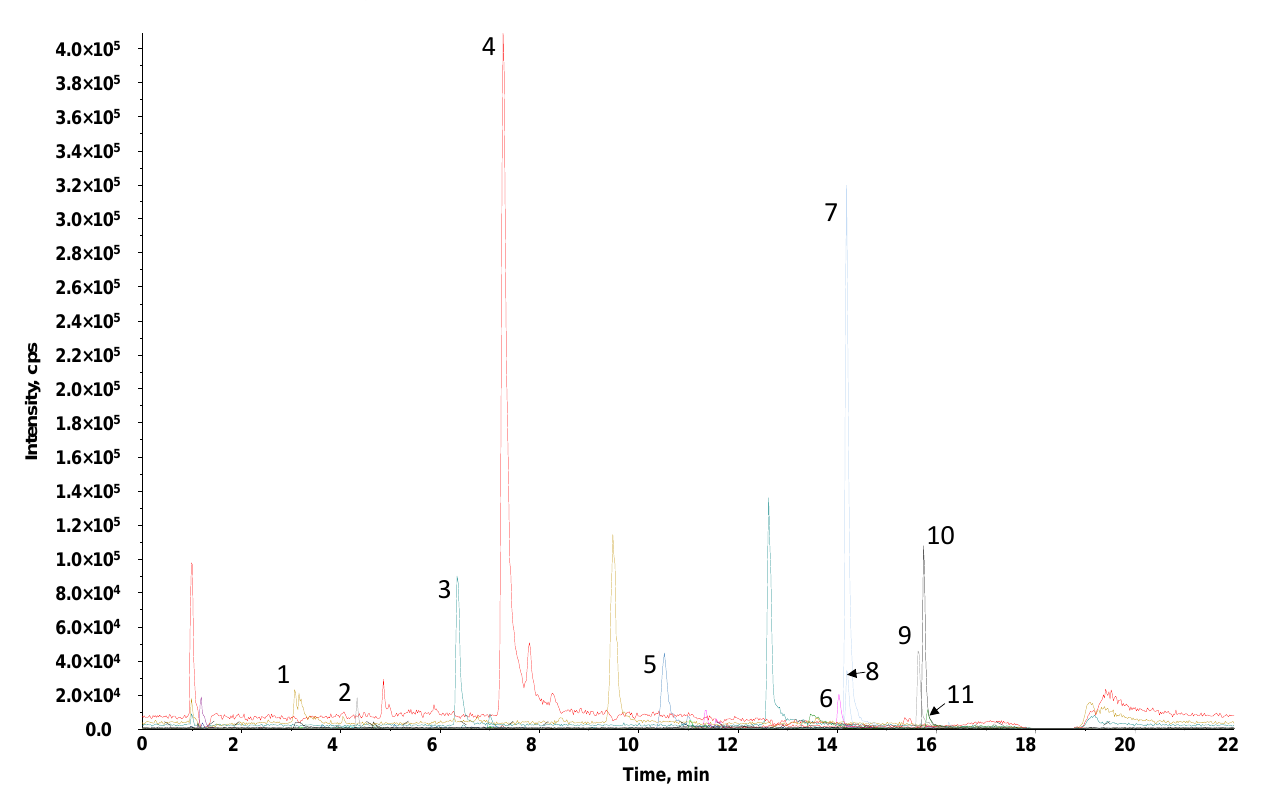
Figure 6. Extracted ion chromatogram of a multifloral honey off-line SPE sample extract analyzed by LC-MS/MS in MRM mode (acquisition conditions are described in Table S4 in Supplementary Materials). Peak identification: 1, gallic acid; 2, 3-hydroxytyrosol; 3, 4-hydroxybenzoic acid; 4, caffeic